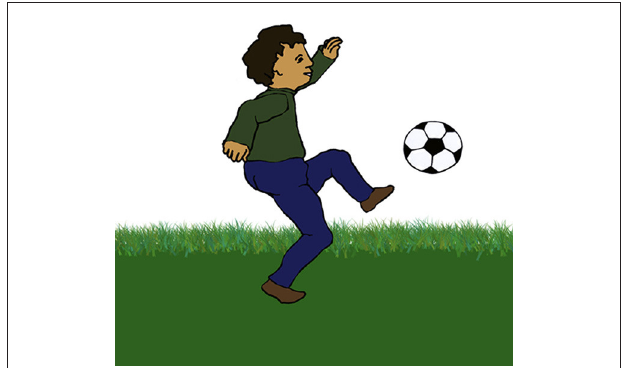
FIGURE 1 | Example stimulus